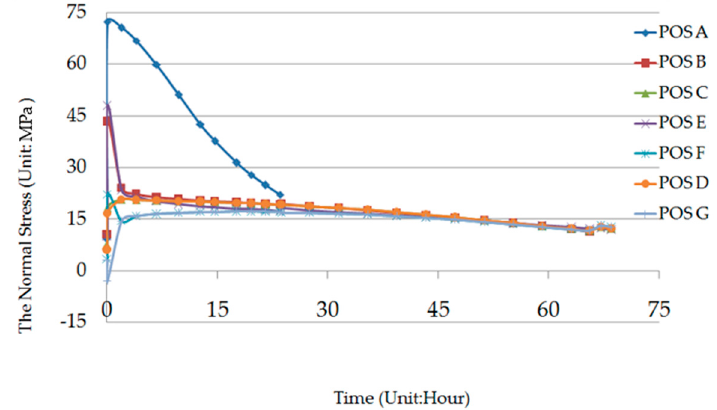
Figure 11. Evolution of the stress at normal direction.